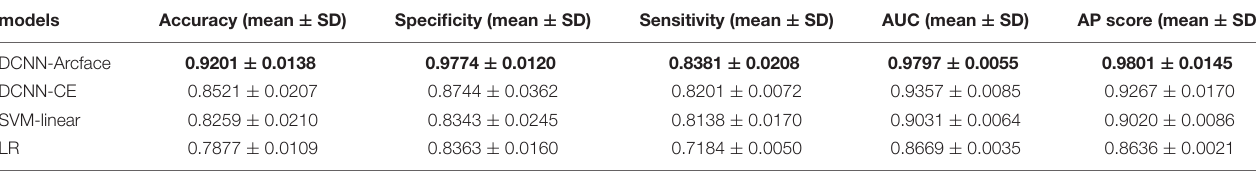
FIGURE 5 | Illustration of two traditional machine learning models. TABLE 3 | The accuracy, specificity, sensitivity, AUC, and AP score of different models at distinguishing Noonan syndrome from healthy children.